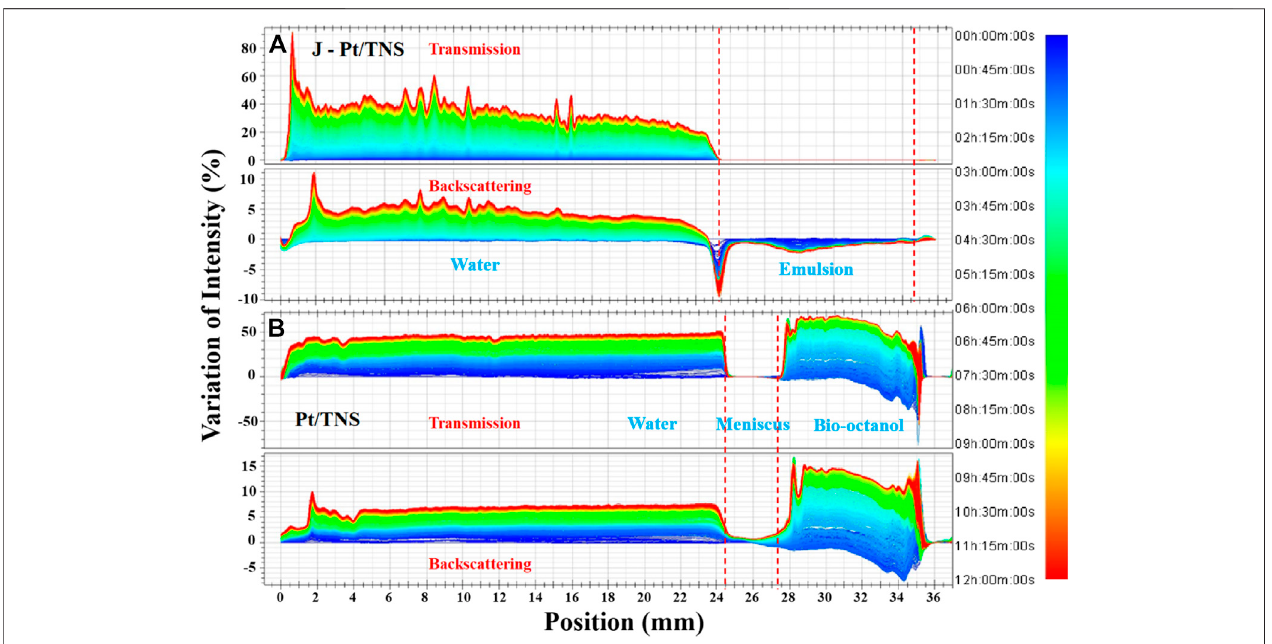
FIGURE 7 | Variations of transmission and backscattering at 25 ° C for the system of (A) J-Pt/TNS and (B) Pt/TNS (stated bottom of bottle was 2 mm).